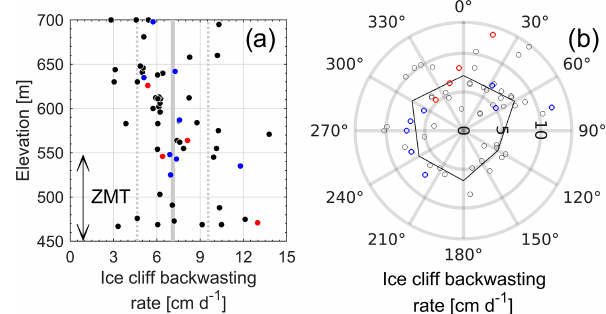
Figure 7. Ice cliff backwasting rate measurements. Ice cliff back- wasting rates are corrected for the different measurement periods (Sect. S1.2). Cliffs with streams at their base are blue. Cliffs with ponds at their base are red. (a) Ice cliff backwasting rate as it varies with elevation. The solid grey line is the mean of all data 7.1cmd − 1 . The dashed lines are ± 1 σ bounds used in the dis- tributed melt calculations. The double-headed arrow represents the zone of maximum thinning (ZMT). (b) Ice cliff backwasting rate as it varies with aspect. The corners in the solid black line represent the mean backwasting rate from 60 ◦ bins. During the field survey, ice cliffs with ponds at their base were only found facing northward (between 300 and 30 ◦